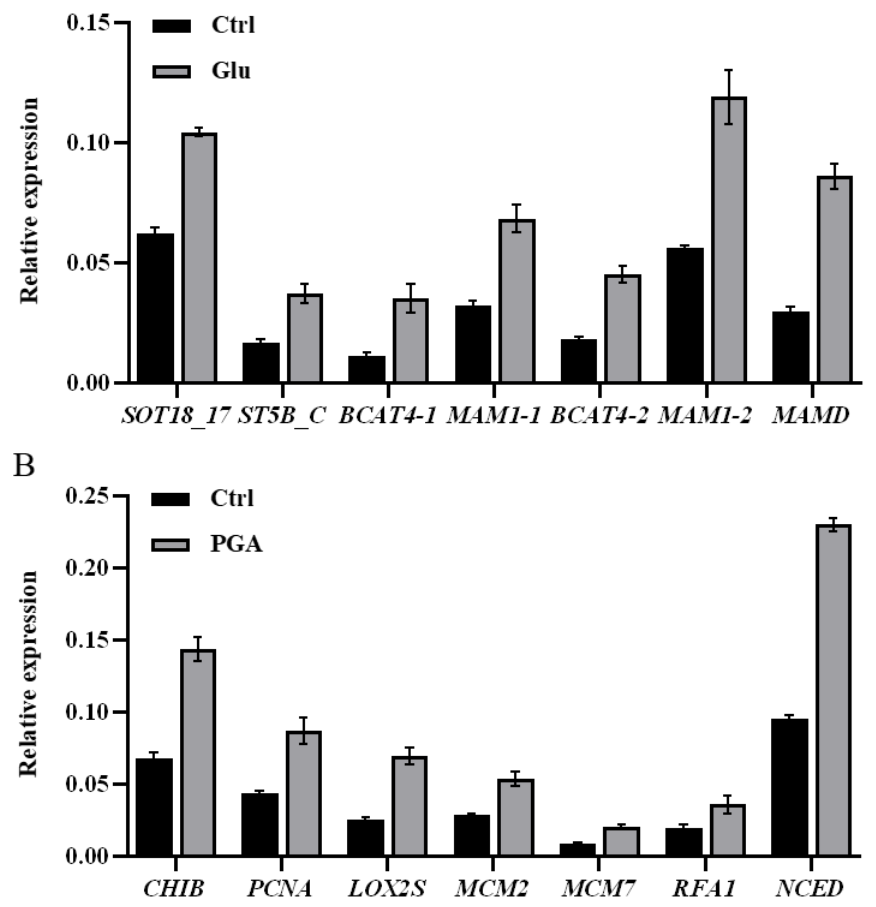
Figure 6. Gene expression pattern verification by qRT-PCR. ( A ) Gene expression of Glu vs. Ctrl. ( B ) Gene expression of γ -PGA vs. Ctrl. CHIB ( BraA03g035760.3.1C ), PCNA ( BraA09g064370.3.1C ), LOX2S ( BraA02g016330.3.1C ), MCM2 ( BraA10g007700.3.1C ), MCM7 (BraA09g002250.3.1C ), RFA1 ( BraA03g003290.3.1C ), NCED ( BraA01g038240.3.1C ).